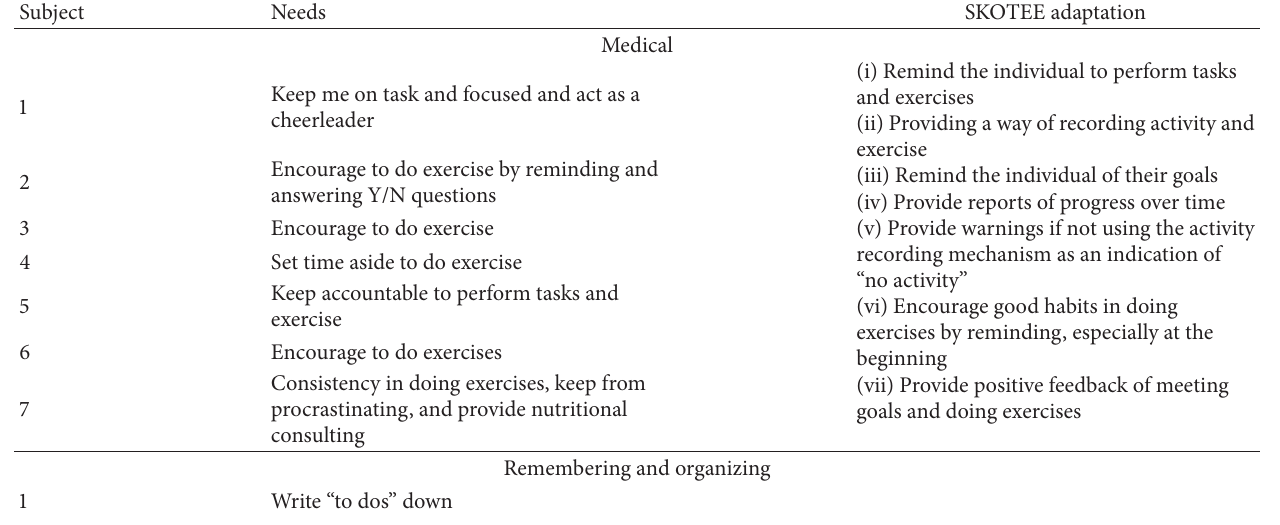
Table 3: Role of a personal coach and SKOTEE